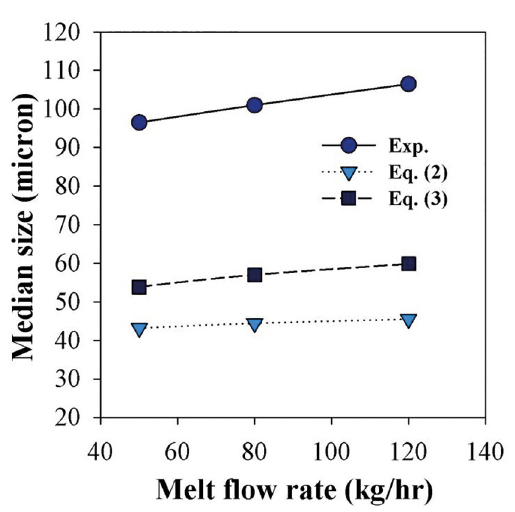
Figure 7. Effect of melt flow rate on median particle size. Rotating speed 30,000 rpm, 60 mm disc diameter, and 550 o C melt